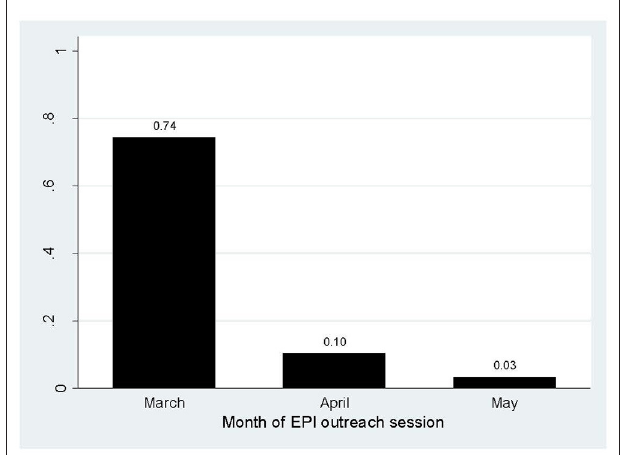
FIGURE 2 | Percentage of EOS conducted by month,